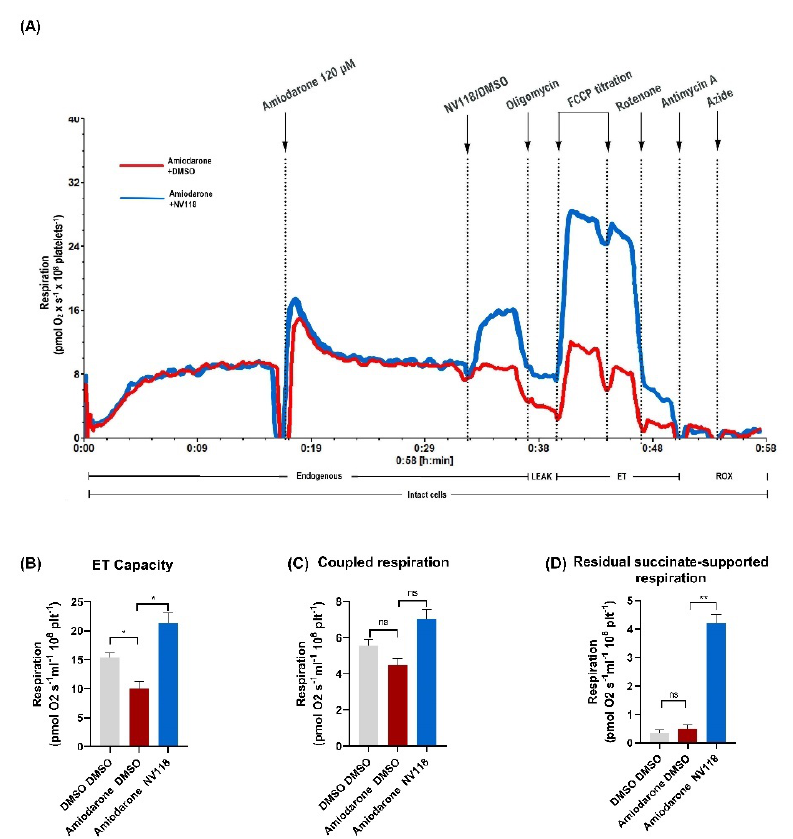
Figure 5. Effects of the succinate prodrug NV118 on amiodarone-induced mitochondrial dysfunction in human platelets . ( A ) Representative trace of amiodarone-exposed platelets in the absence (red) or presence (blue) of NV118. ( B – D ) NV118 effects on amiodarone-exposed platelets (blue) were measured as compared to its vehicle (DMSO, red). As negative control platelets were exposed to only DMSO (grey). Data were expressed as mean ± SEM. One-way ANOVA with Bonferroni post hoc test was performed on the antimycin-corrected data. DMSO: dimethyl sulfoxide. FCCP: carbonyl cyanide p -(trifluoromethoxy) phenylhydrazone. LEAK: non-phosphorylating respiration. ET: electron transfer. ROX: residual oxygen consumption. ns = not significant. * p < 0.05; ** p < 0.01 vs. DMSO. n =